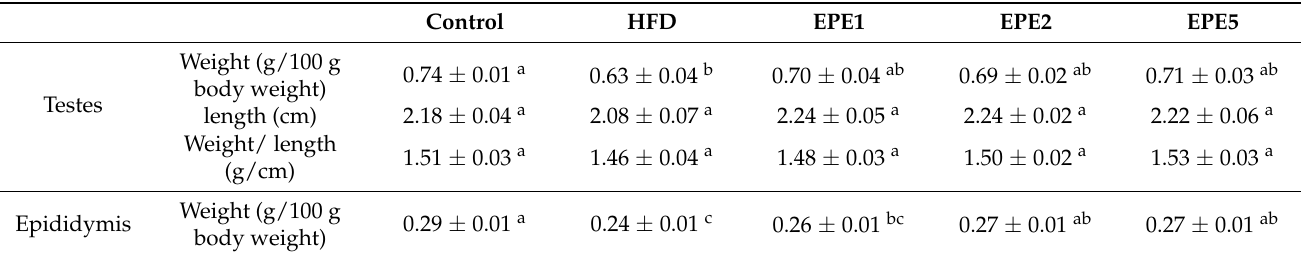
Table 2. Effects of Echinacea purpurea ethanol extract on testes and epididymis weight in HFD-induced obese rats after 5